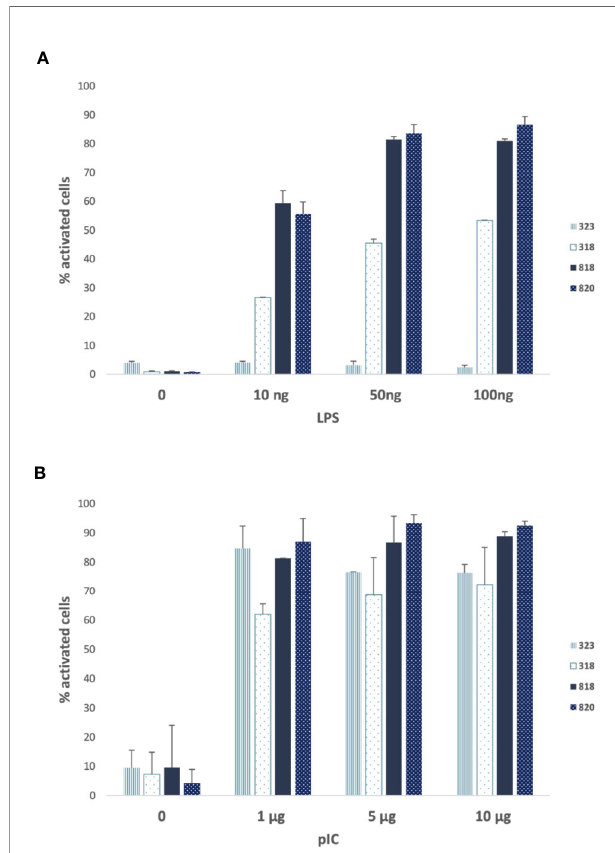
FIGURE 3 | Poly (I :C) and lipopolysaccharide (LPS) responses of 323 cells compared to 318, 818, and 820 cells. (A) Percentage of cells with nuclear nuclear factor-kappa B (NF- k B) (activated) for donors ’ fi broblasts (318, 323, 818, 820) activated with 10, 50, and 100 ng of LPS or non-stimulated (0). (B) Percentage of cells with nuclear NF- k B (activated) for donors ’ fi broblasts (318, 323, 818, 820) activated with 0, 1, 5 and 10 µg of Poly (IC) or non- stimulated (0). 318, 323: men age 30 – 39 and 818, 820: women age 60 – 69. Low responders are shown in light blue and high responders in dark blue. Bars plot the mean ± sd of triplicates of each experimental